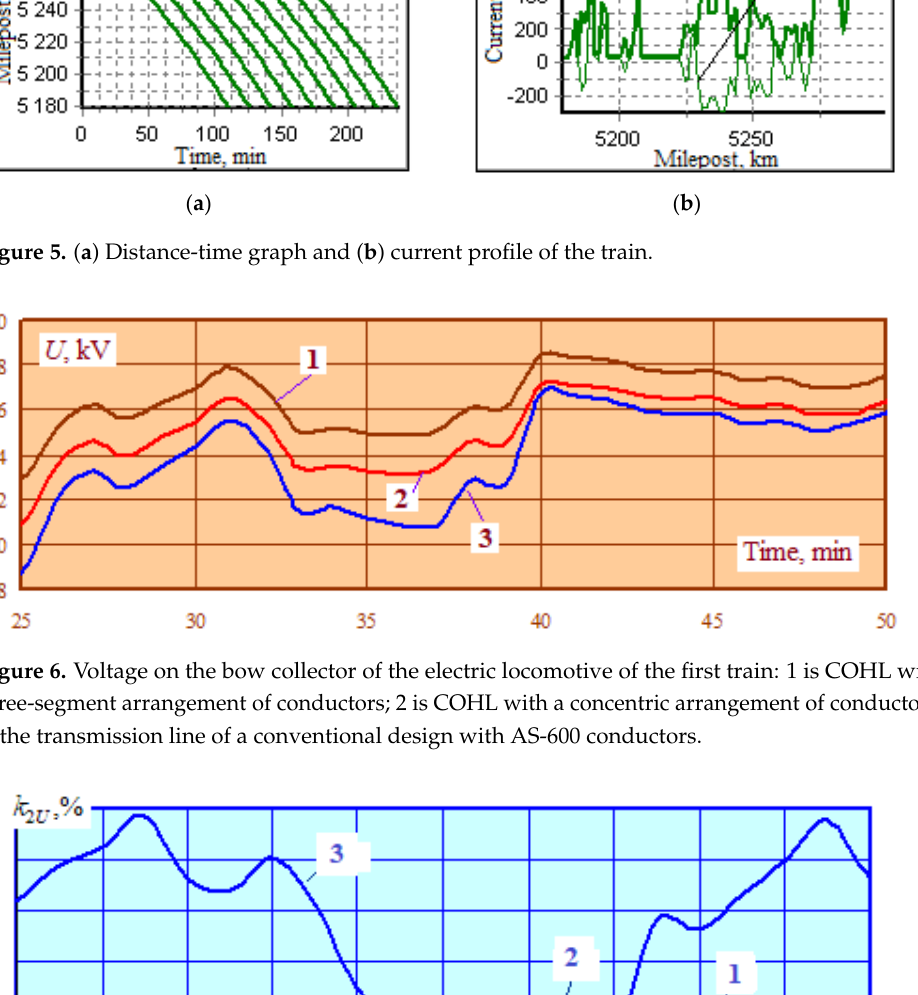
Figure 8. Power losses in the traction network of the middle inter - substation area—callout numbers correspond to those in Figure 6.